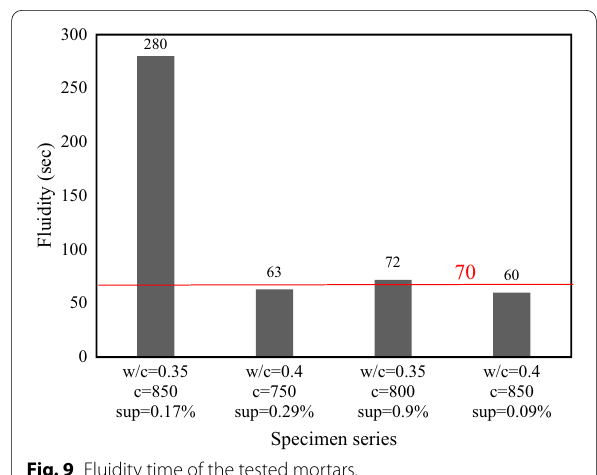
Fig. 9 Fluidity time of the tested mortars.